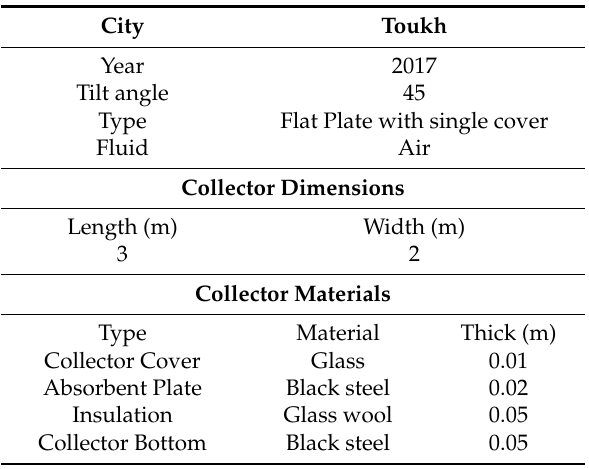
Table 3. Data of the used solar collector.